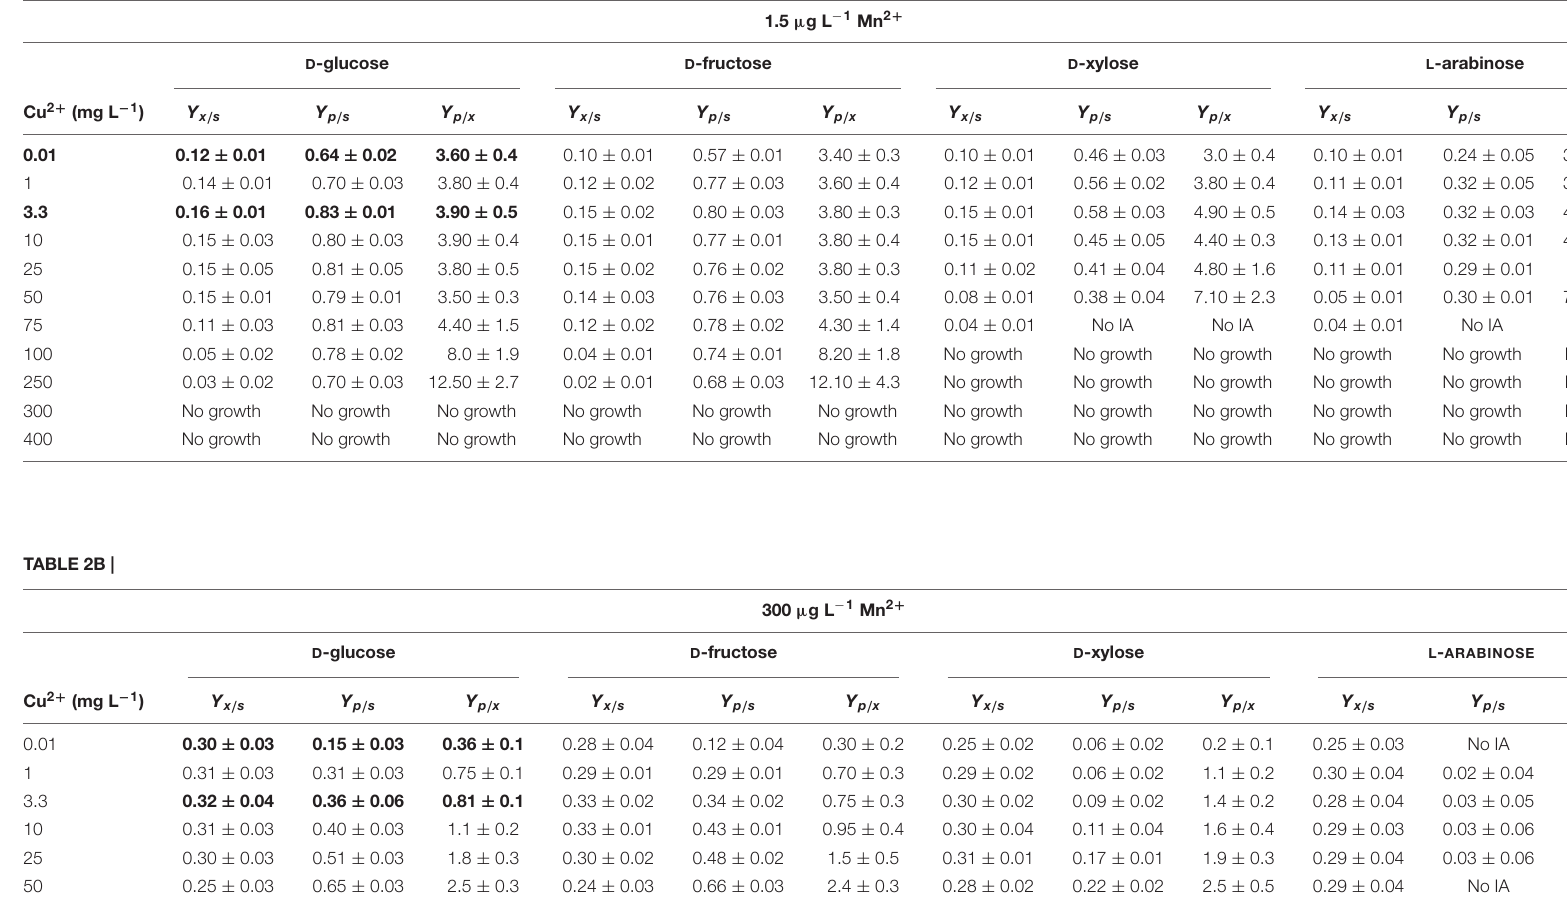
TABLE 2A | Specific molar itaconic acid yield ( Y p / s ), biomass-specific itaconic acid yield ( Y p / x ) and biomass yield ( Y x / s ) of Aspergillus terreus NRRL1960 cultures as a function of the copper(II) ion concentration in the culture broth.